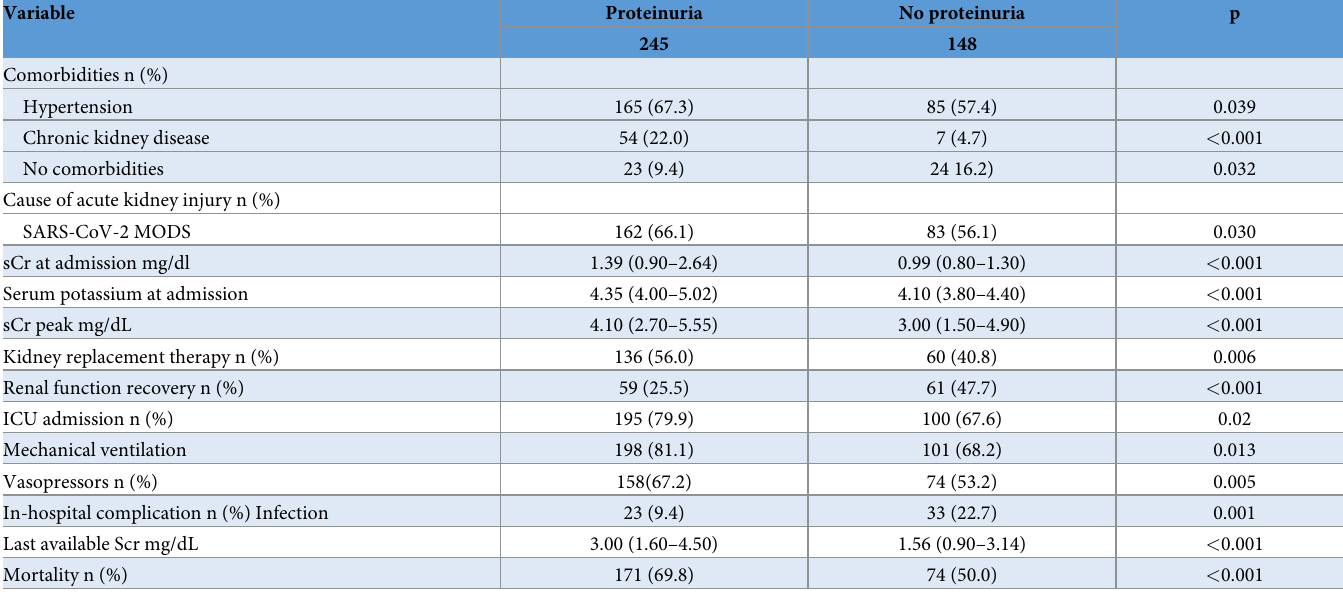
Table 3. Clinical characteristics of patients with proteinuria at admission. Subgroup